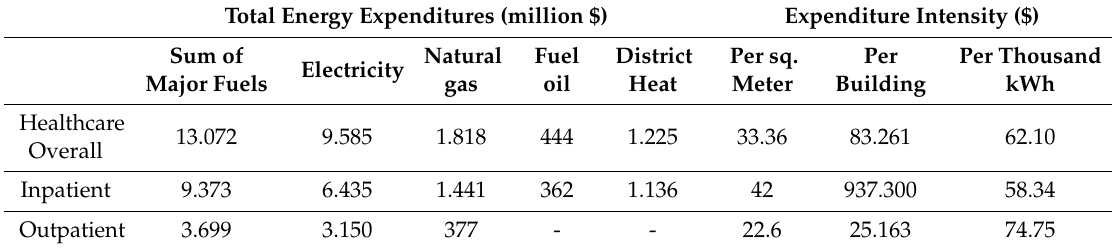
Table 3. Energy cost